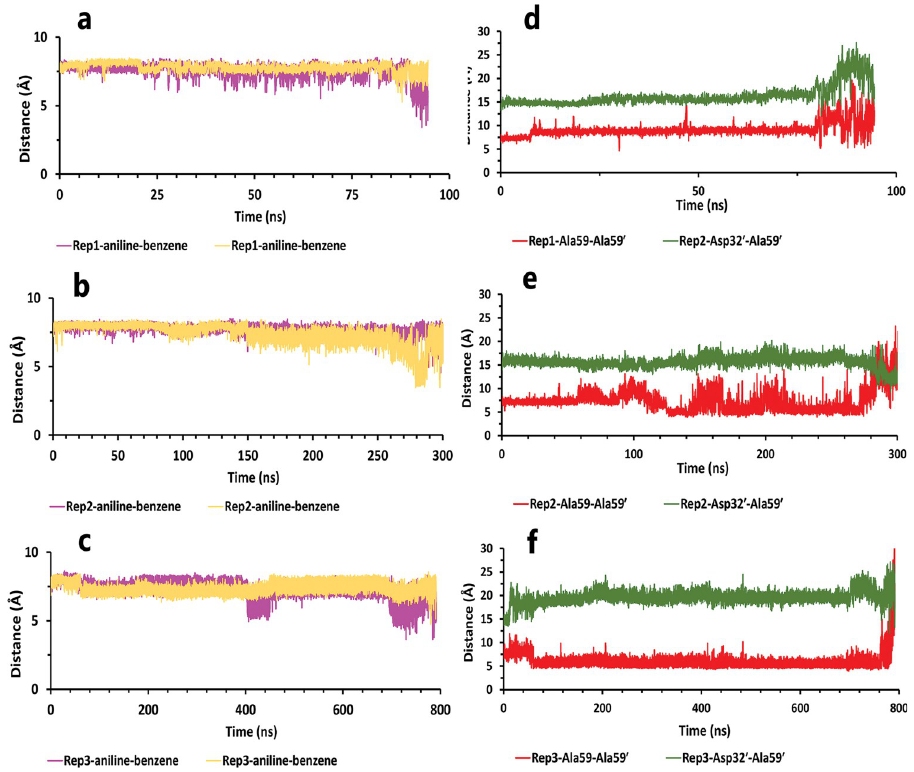
Fig 8. The details of distances between particular parts in compound 10 in complex with HTLV-1 protease, when Asp32 of chain B was protonated, in three replicas. A , B , and C , The distance between COMs of both aniline rings and benzene rings, which were in a position that could form pi-pi intramolecular interactions in all replicas. These plots prove that these fragments were so close together during the simulation. D , E , and F , The distance between COMs of Ala59 andAla59 0 and also Asp32 0 Ala59 0 in all replicas (these plots should be checked with Fig